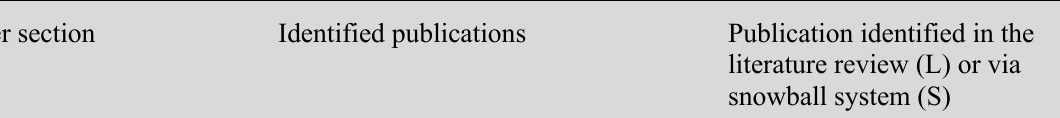
Table A2. Identified literature about the differences between P-PES and C-PES against the background of land tenure structures, as well as the potentials and challenges of C-PES, also in relation to commodification processes; cited literature is assigned to the subsections of the second and third results chapter and divided into publications directly identified in the literature review and further publications identified based on the snowball